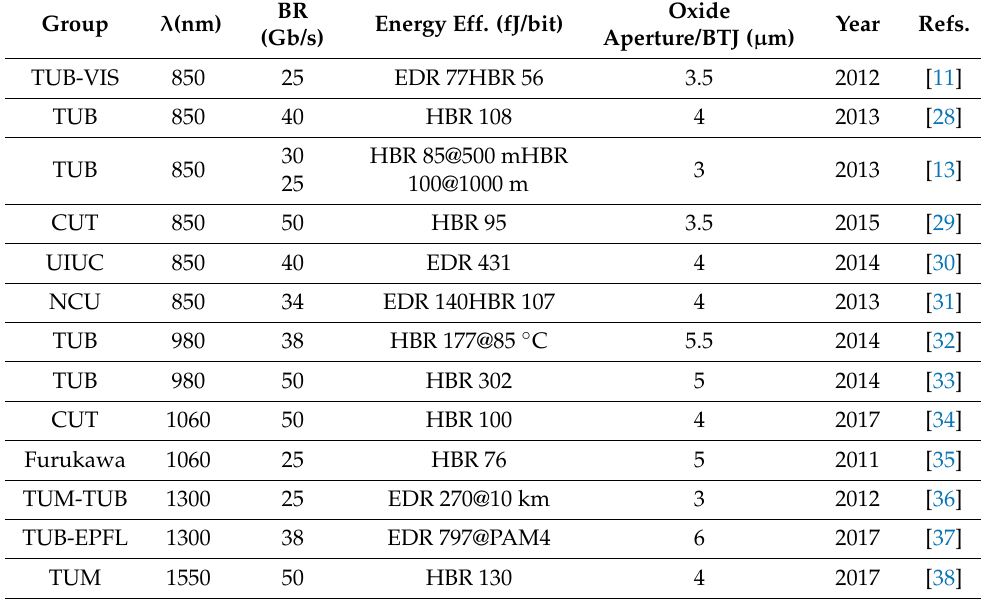
Table 1. Energy Efficiencies of High-Speed VCSELs. Energy Eff. Group λ (nm) (Gb/s)